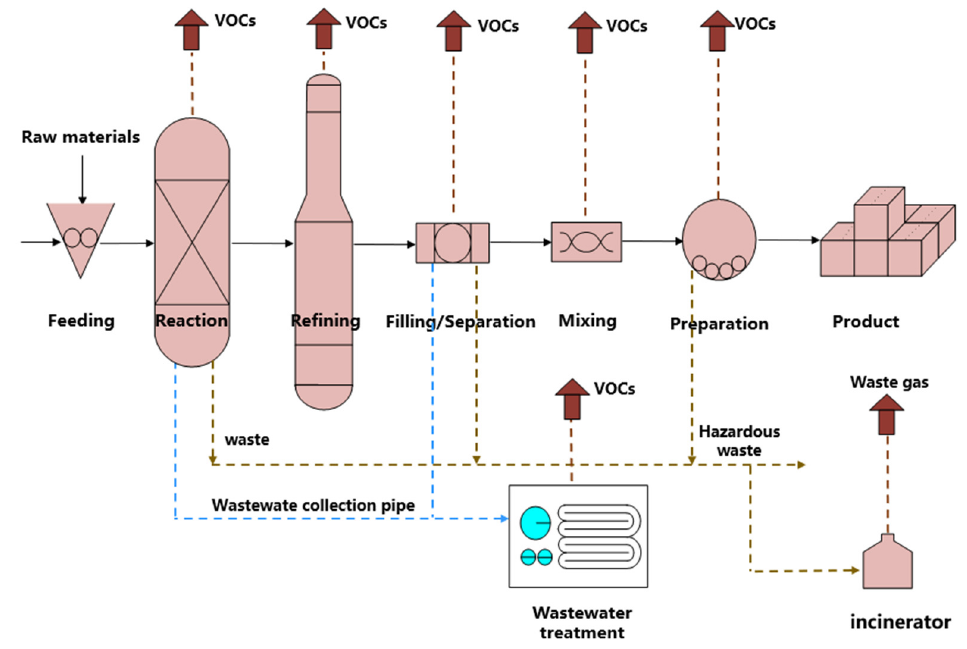
Figure 1. The process flow diagram of the pesticide factory. Table 2. Characteristics of VOC emissions in the pesticide industry.